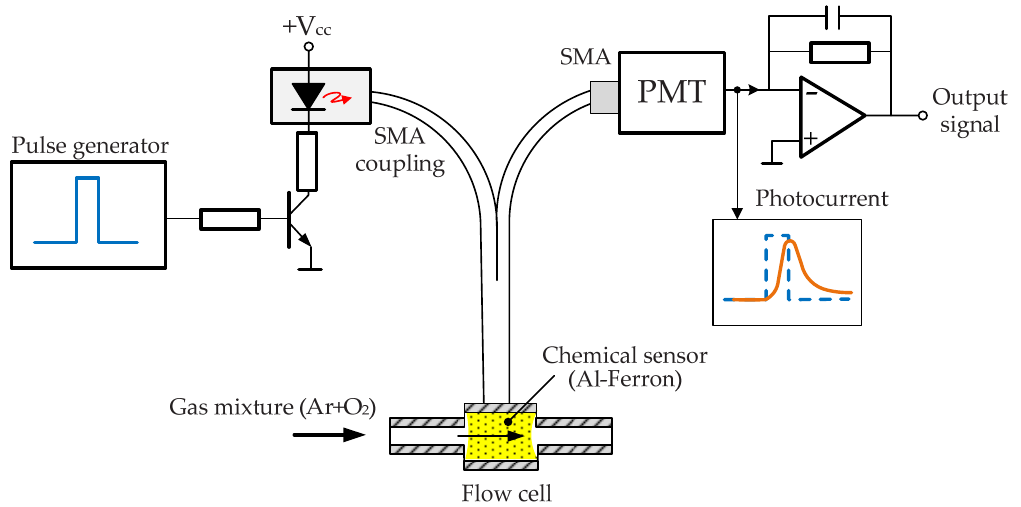
Figure 18. Design of an optical oxygen sensor based on phosphorescence lifetime measurements.